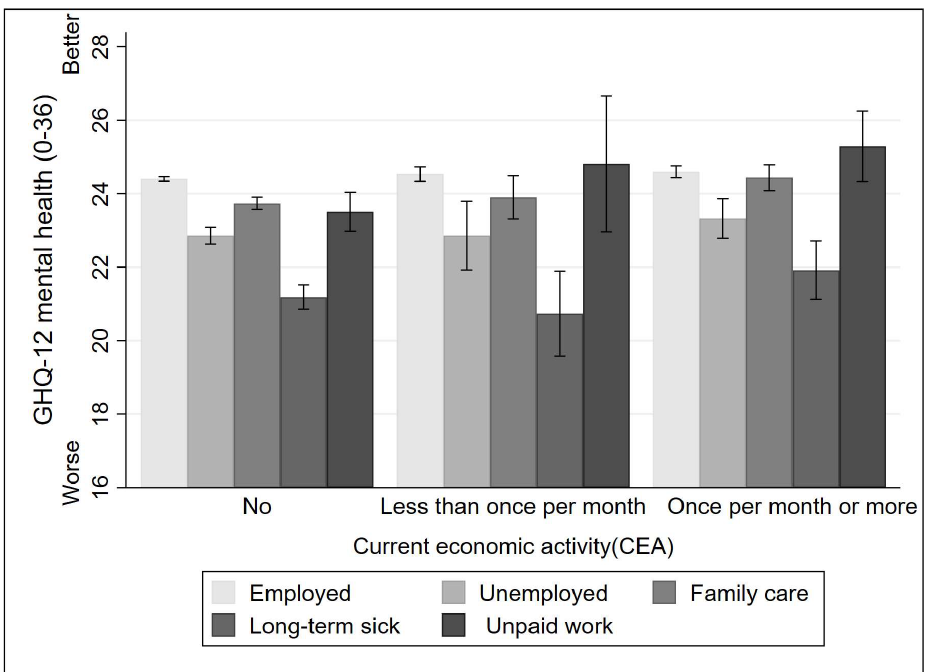
Figure 2. Differences in mental health between volunteering frequency distinguish current economic activity (Women).